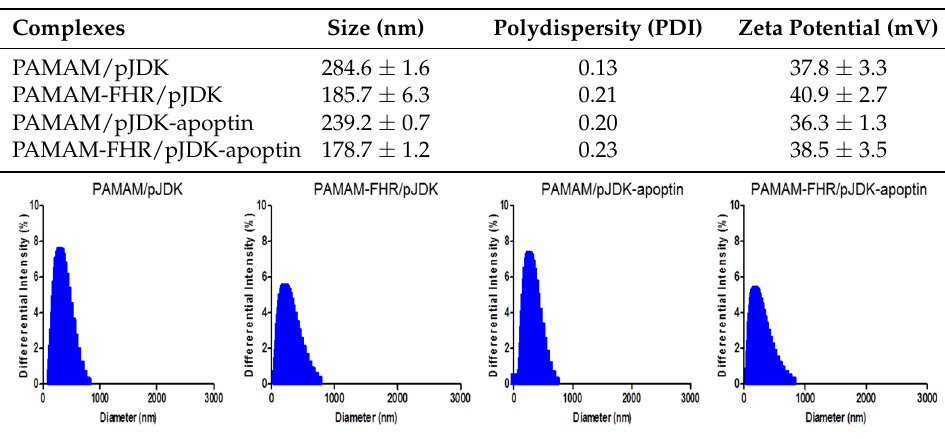
Figure 1. Gel electrophoresis and PicoGreen assays of pJDK-apoptin complexes. ( A , B ) each polymer/DNA complex at different weight ratios (0, 1, 2, 4, and 8). Each lane is the weight ratio of polymer/DNA. The DNA concentration was 0.5 µg/µL. ( C ) Complexes were prepared under the same conditions as those used for the gel retardation. The intensity was normalized to 100% in pJDK and pJDK-apoptin plasmid DNA. Results are shown as the mean ± standard deviation, n = 3. Table 1. The characteristics of mean diameter, polydispersity, and zeta potential values of polymer/ pJDK or pJDK-apoptin complexes.